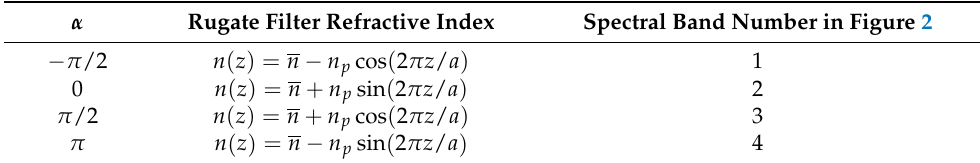
Table 1. The RF refractive indices used for numerical calculations.